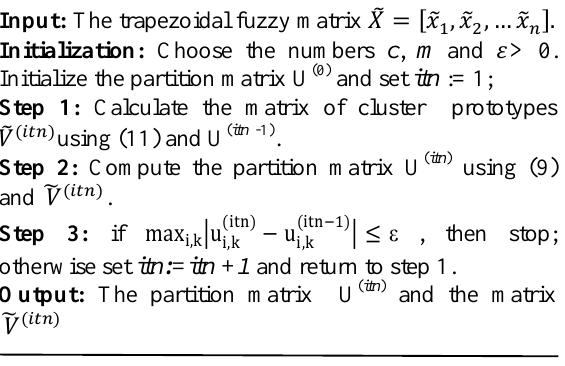
Algorithm 1 Clustering complete fuzzy